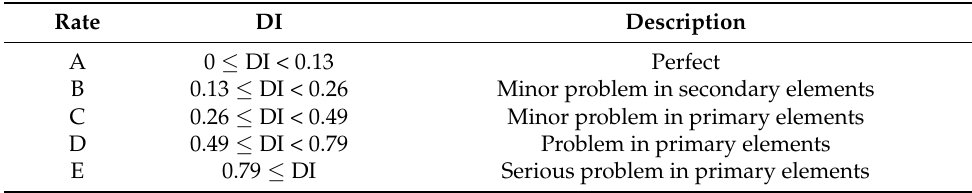
Table 4. Assessment of bridge condition in